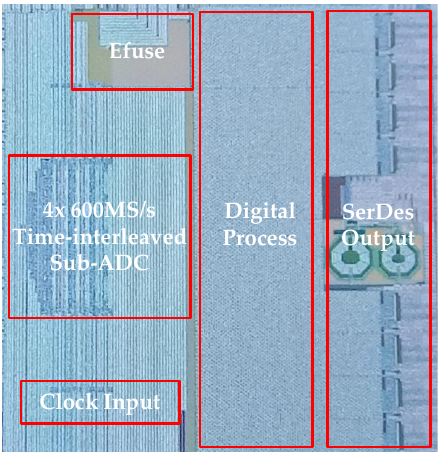
Figure 12. Prototype ADC micrograph.